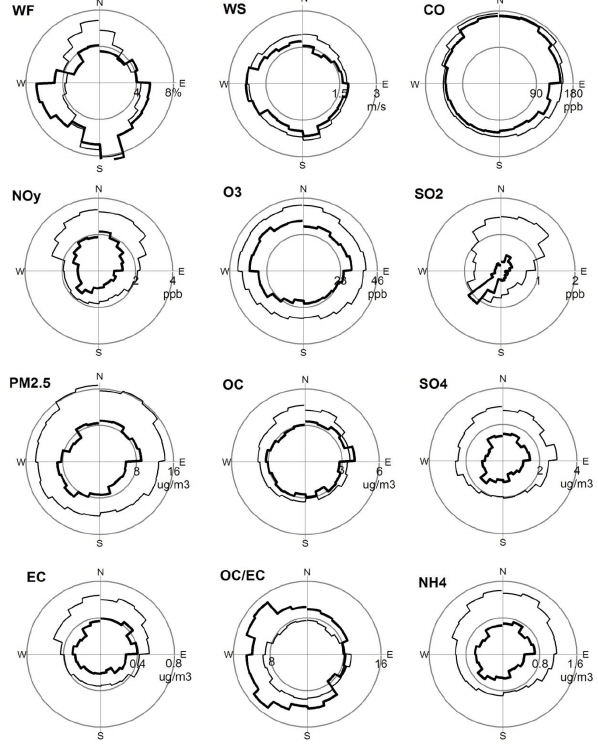
Figure 13. Comparison between average 1 June–15 July, 2000– 2012 and the SOAS period of 1 June–15 July 2013 for directional for directional wind speed frequency and direction, trace gas concentrations, and 1733 wind speed frequency and direction, trace gas concentrations, and concentrations of PM 2 . 5 mass, EC, OC, SO 4 , NH 4 , and OC/EC at